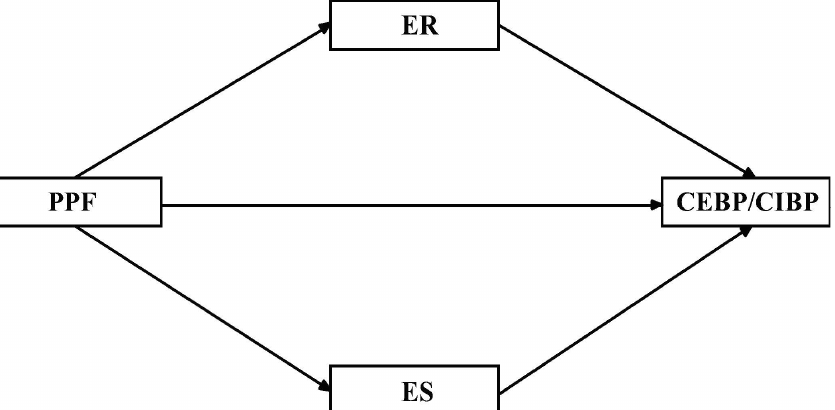
Figure 1. Hypothetical model diagram of the effects of parental psychological flexibility on chil- dren’s externalizing and internalizing behavior problems. PPF = parental psychological flexibility, ER = emotional regulation, ES = emotional stability, CEBP = children’s externalizing behavior prob- lems. CIBP = children’s internalizing behavior problems.